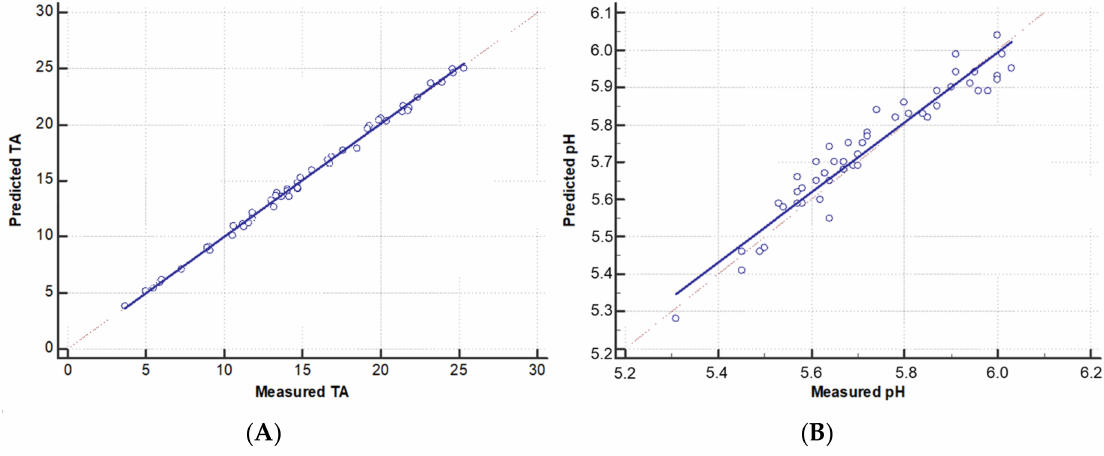
Figure 1. Scatter-plot with the regression line (calculated according to the Passing-Bablok method) and the identity line for the measured and predicted values of titratable acidity (TA), ( A ) and pH ( B ). TA is expressed in millimoles of NaOH added until pH =